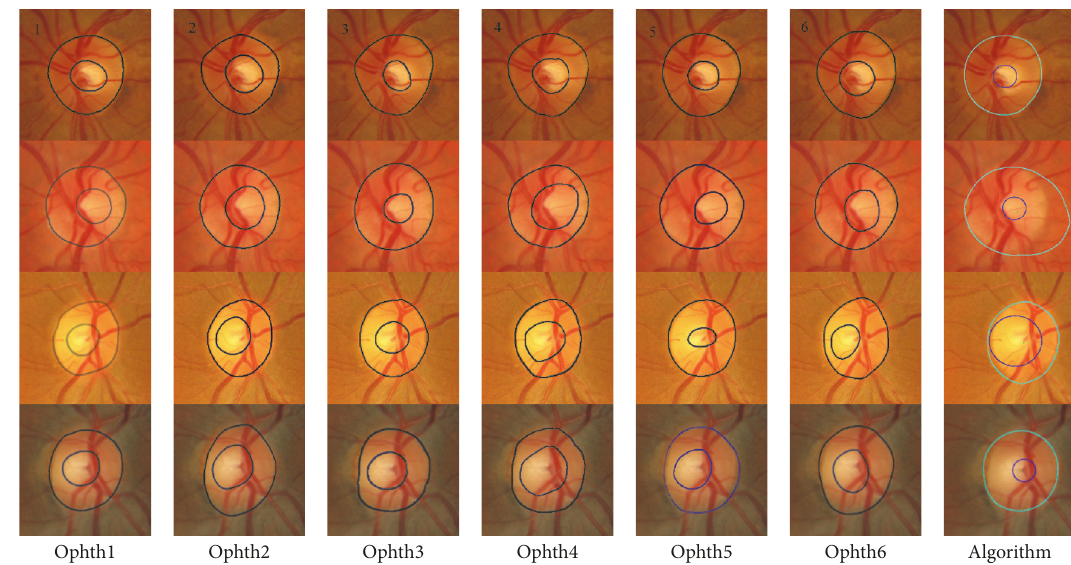
Figure3:Examplesofpoorsegmentationresultsforhorizontalcuptodiscratio.Eachrowshowstheresultsforasampleimage. Theimageson each row (left to right) show the results of manual markings by the six ophthalmologists (1 to 6) and the automatic marking by the algorithm (far